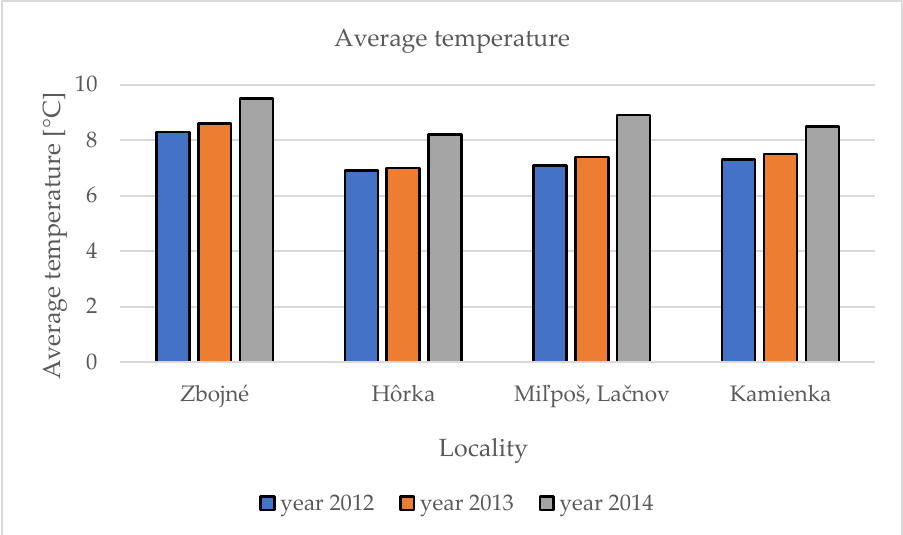
Figure 2. Average temperature in five localities during three observation years.